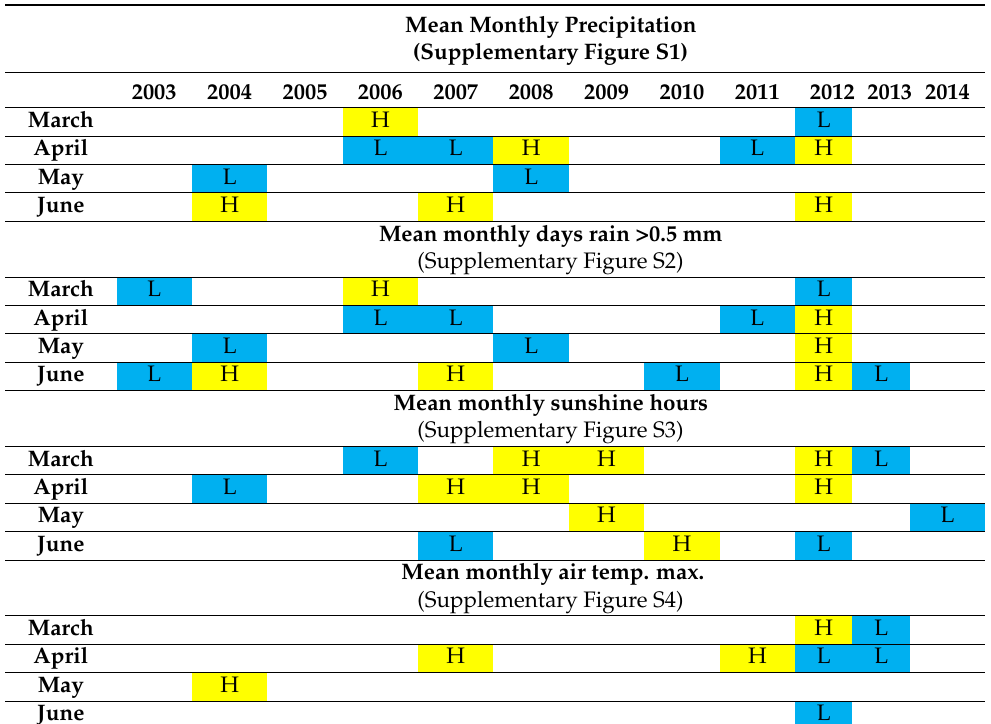
Table 2. Comparison of notable high or low precipitation, sunshine and air temperature maximum monthly figures from 2003 to